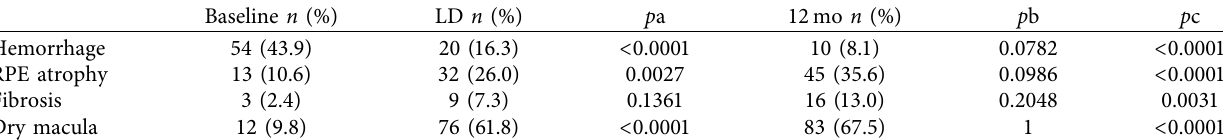
Figure 2: Presence of retinal findings during the period of study. (a) Changes in the percentage of eyes with subretinal fluid (SFR), intraretinal fluid (IRF), and hemorrhages, at baseline, after the loading dose (LD), and at 12 months (12mo), were significant ( ∗ ). (b) Changes in the percentage of eyes presenting retinal pigment epithelium (RPE) atrophy and subretinal (SR) fibrosis, at baseline, after the LD, and at 12 mo, were also significant ( ∗ ). Table 2: Prevalence of eyes with hemorrhage, RPE atrophy, subretinal fibrosis, and dry macula at baseline, after the loading dose (LD), and at final follow-up period